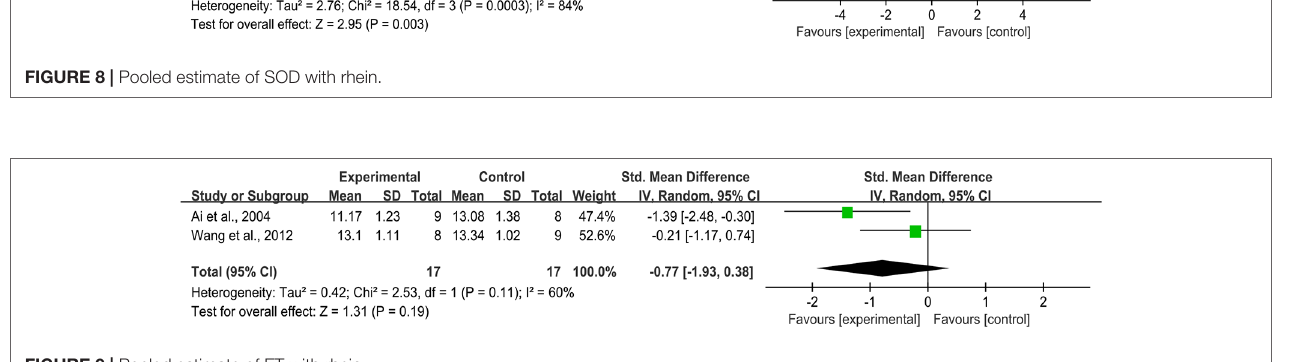
FiGURe 9 | Pooled estimate of ET with rhein.